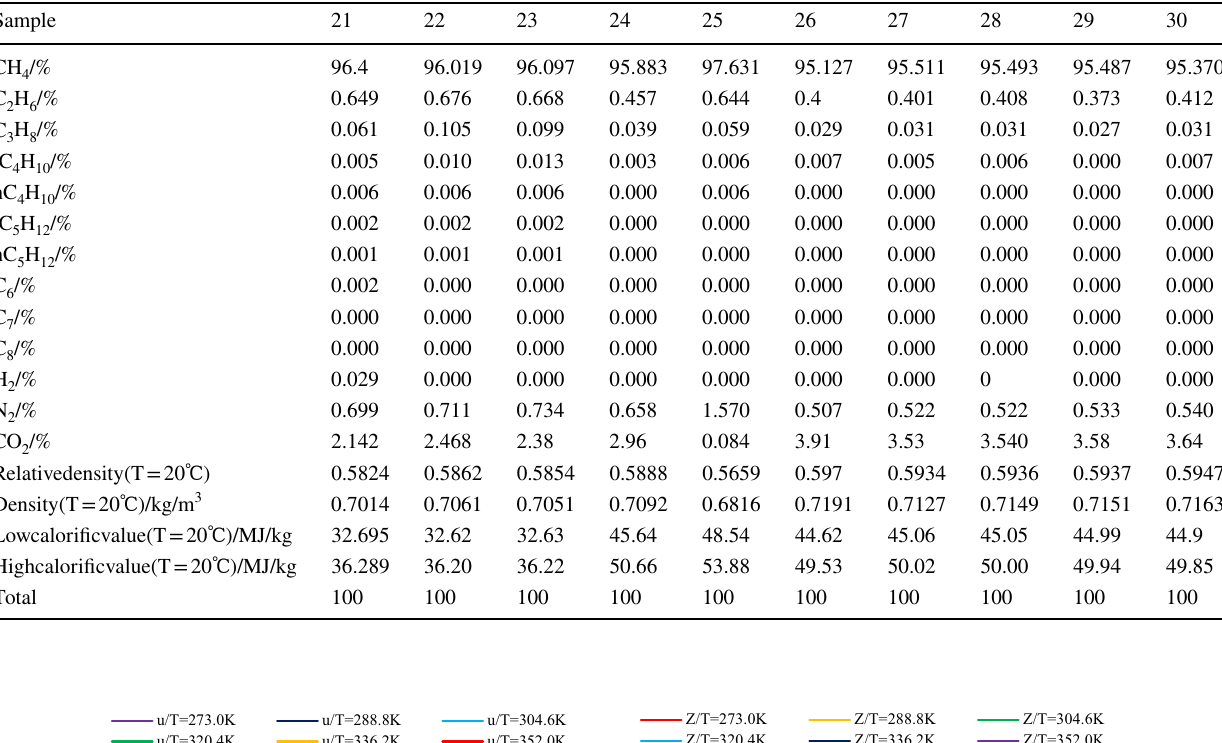
Table 4 Composition of 30 groups of natural gas samples-c Sample